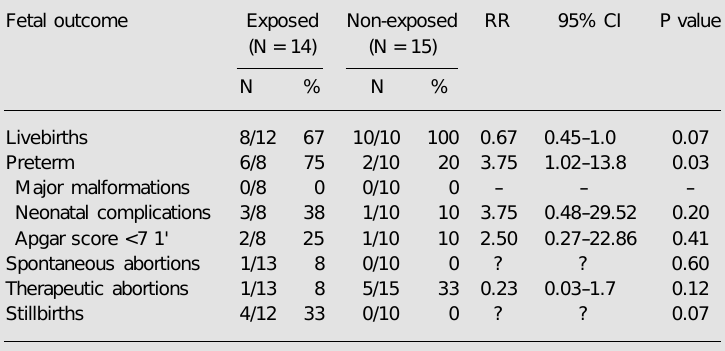
Table 2. Comparison of fetal outcome between exposed and non-exposed patients. Fetal